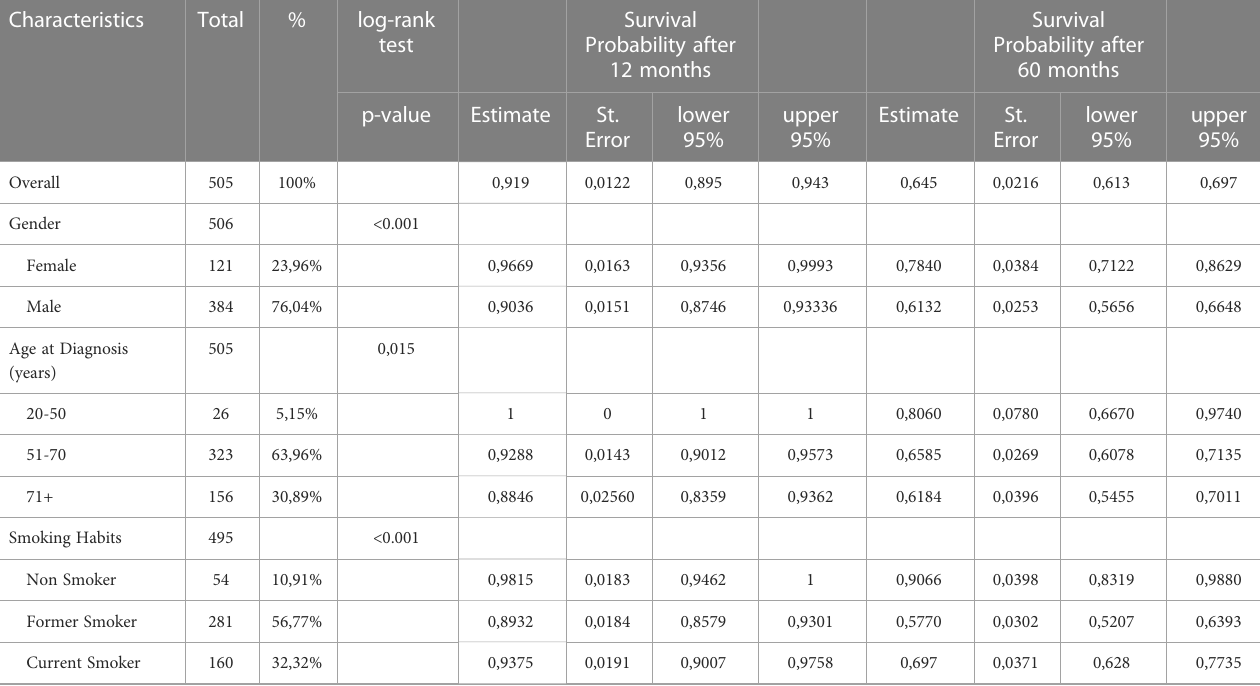
TABLE 2 Univariate analysis of survival probability using Kaplan Meier estimates after 12 months and after 60 months. Characteristics